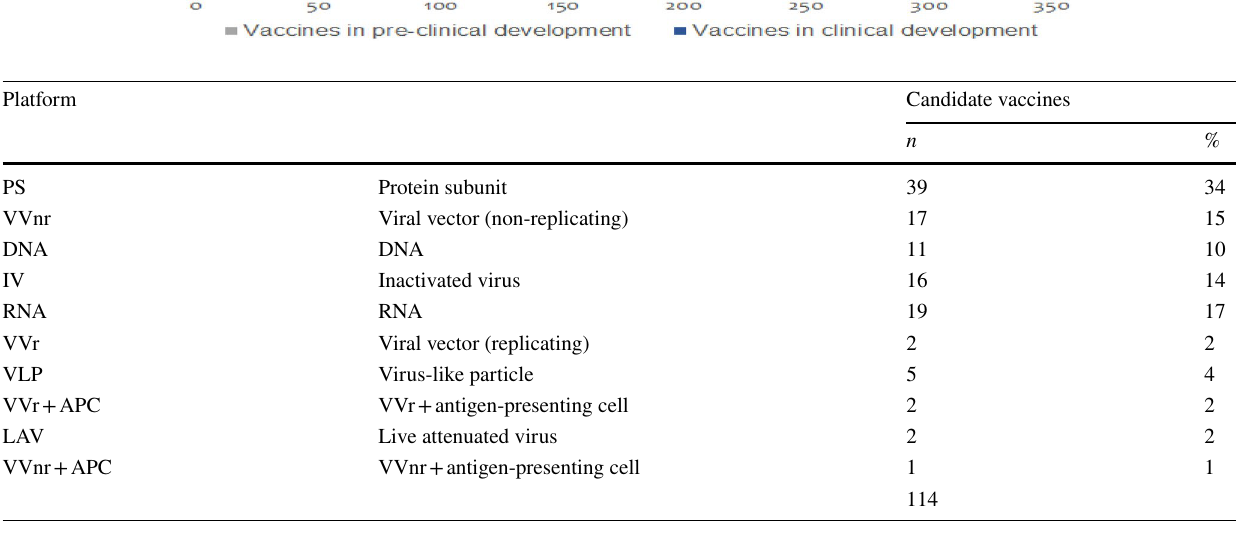
Table 3 Different SARS-CoV-2 vaccine platforms in terms of the number of doses and schedule Number of doses and schedule